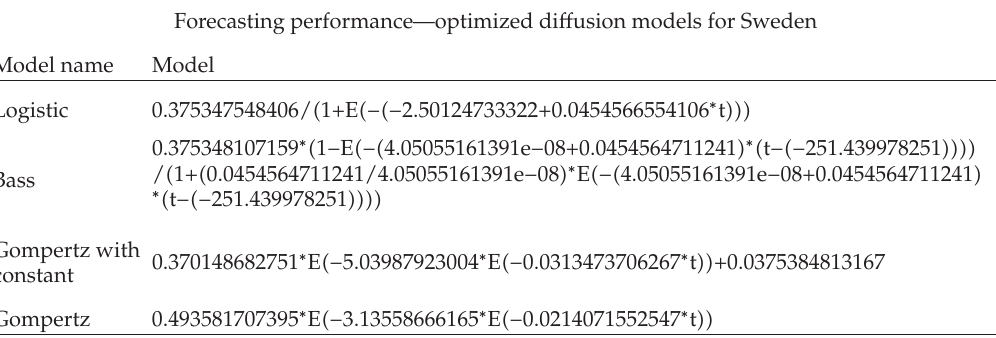
Table 32: Representation of the optimized di ff usion models in forecasting (cid:2) Sweden (cid:3) . Forecasting performance—optimized di ff usion models for